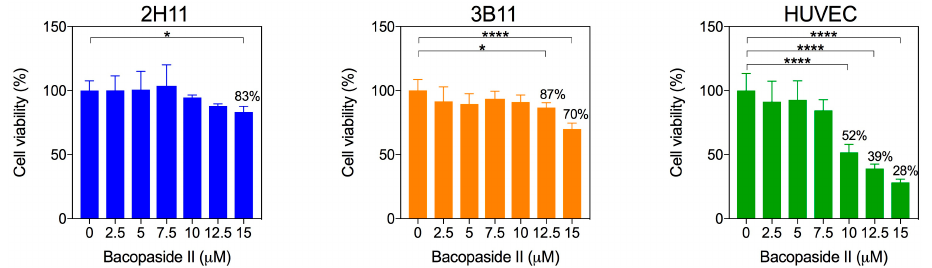
Figure 2. Bacopaside II decreased viability. Cells were treated with bacopaside II for 20 h, and viability was determined by the MTS assay. Data are shown as the mean ± SD ( n = 6 per treatment group). Asterisks represent significant differences relative to the vehicle control (* p < 0.05; **** p < 0.0001). The proportion of cells undergoing apoptosis following treatment with bacopaside II was measured to determine whether this accounted for the reduction in cell viability at higher concentrations. Apoptosis was determined following 8 h of treatment with bacopaside II to correspond to similar time points monitored in the wound closure assay. There was a dose- dependent increase in the number of cells undergoing apoptosis (early and late) for both mouse endothelial cell lines and HUVECs (Figure 3). The increase in apoptosis with 10, 12.5 and 15 μ M bacopaside II relative to that with vehicle was 3%, 12% and 38%, for 2H11 (Figure 3A,B), 1%, 22% and 50% for 3B11 (Figure 3C,D) and 6%, 7% and 32% for HUVEC (Figure 3E,F).